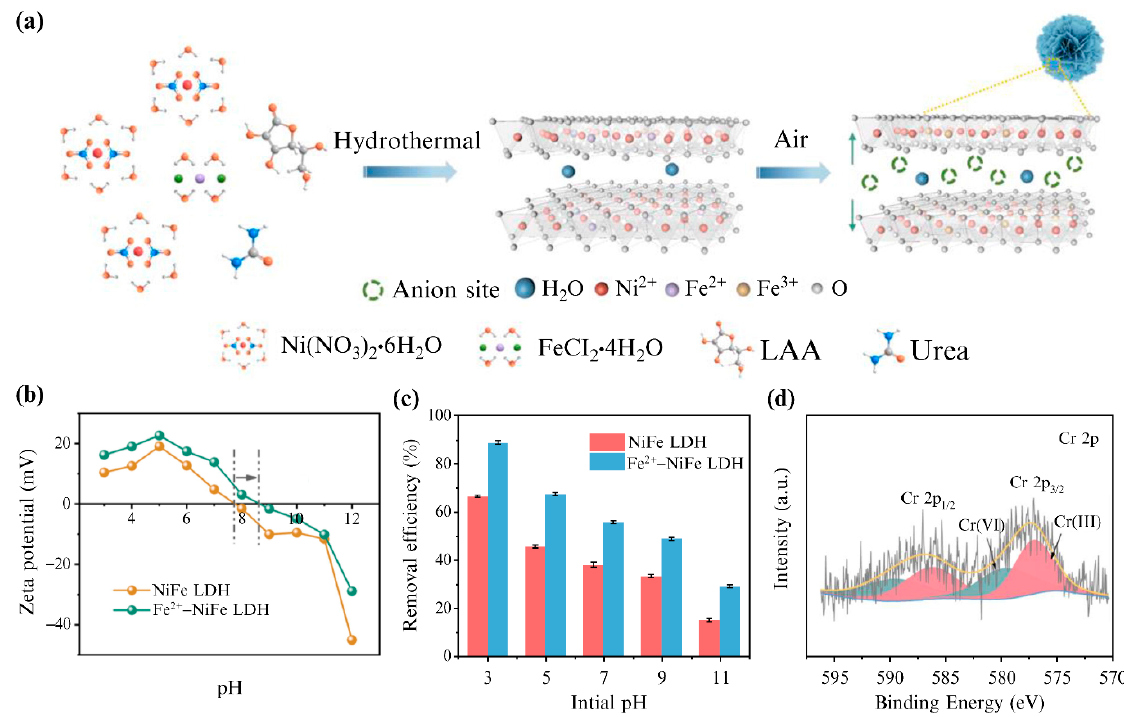
Figure 7. ( a ) Schematic illustration of the synthesis of Fe 2+ − NiFe LDH; ( b ) zeta potential of Ni − Fe LDH and Fe 2+ − NiFe LDH as a function of pH; ( c ) e ff ect of the initial pH on Cr(VI) removal by Ni − Fe LDH and Fe 2+ − NiFe LDH; ( d ) Cr 2p spectrum of Fe 2+ − NiFe LDH after Cr(VI) adsorption. Repro- duced with permission from [57].